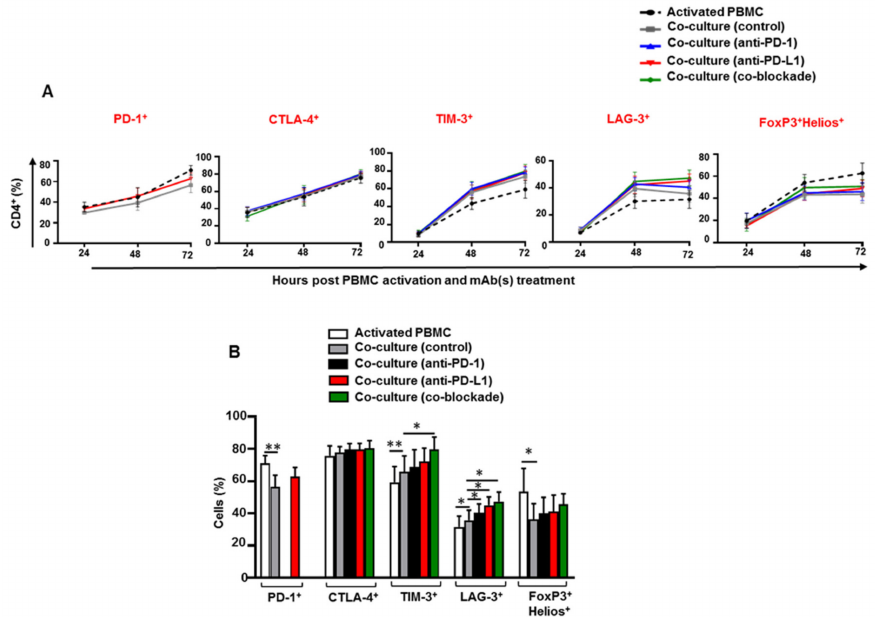
Figure 1. Kinetics of immune checkpoint expression on CD4 + T cells in co-culture with MDA-MB-231 cells. Activated peripheral blood mononuclear cells (PBMCs) co-cultured with MDA-MB-231 cells